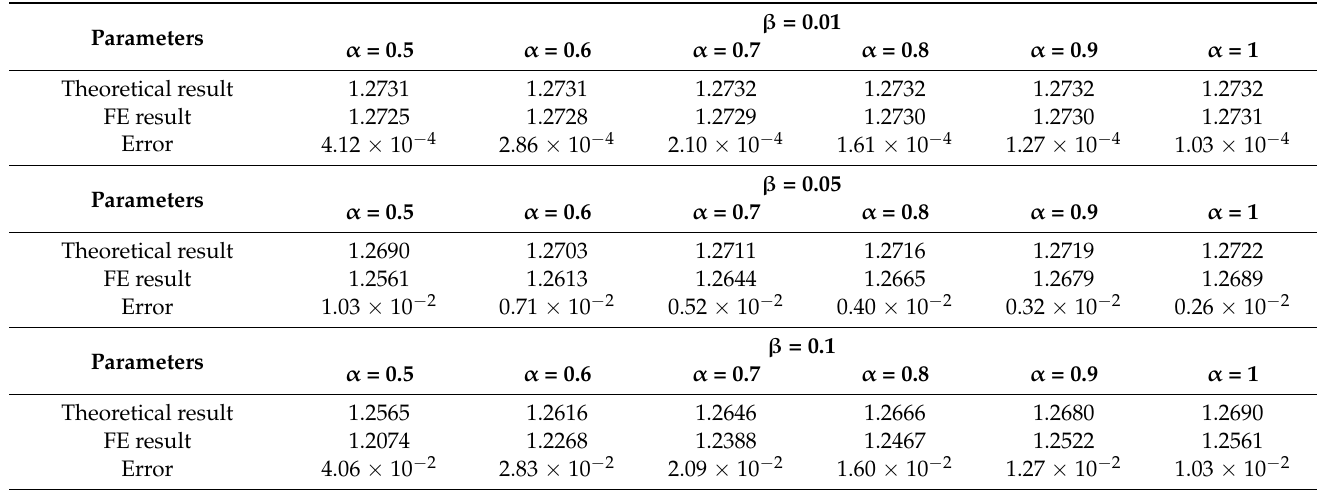
Table 2. Errors between theoretical and FE results.